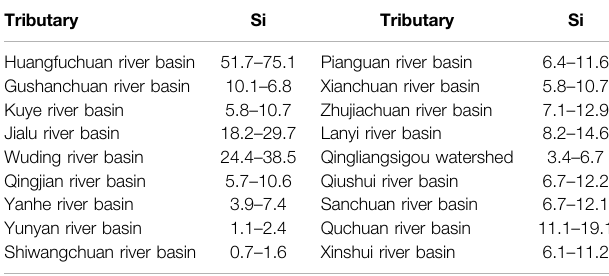
TABLE 3 | Goodness-of- fi t test results of the P 50 and P 100 seriesin the study area TABLE 4 | Sediment yield index of the main tributaries in the HLR under current underlying surface conditions [t/(km 2 mm)]. Tributary Si Tributary